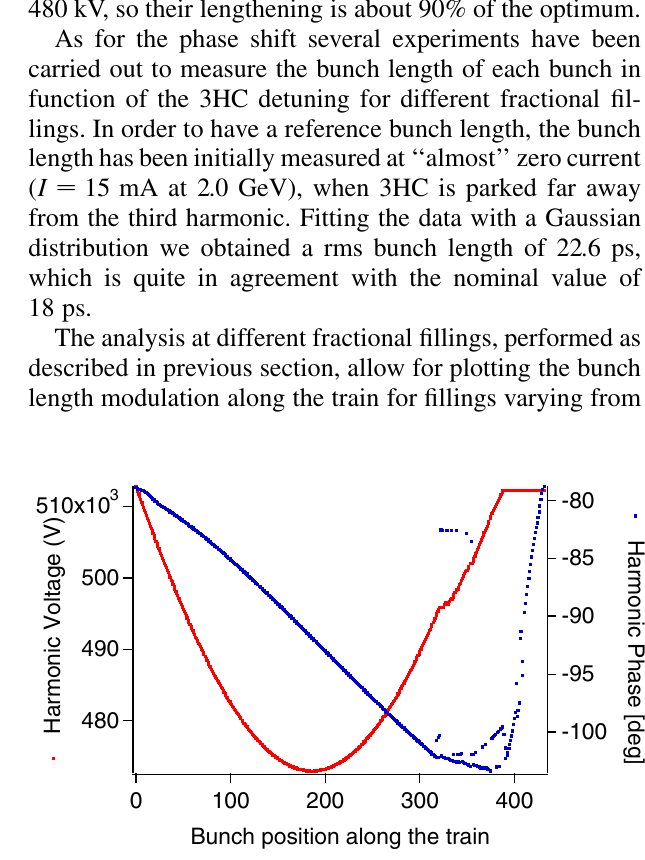
FIG. 9. (Color) ESRF code results of the harmonic voltage (red) and phase (blue) modulation along the bunch train after the transient beam loading, obtained for a beam current of 315 mA, a 90% filling and a 3HC detuning of (cid:7) 81 kHz